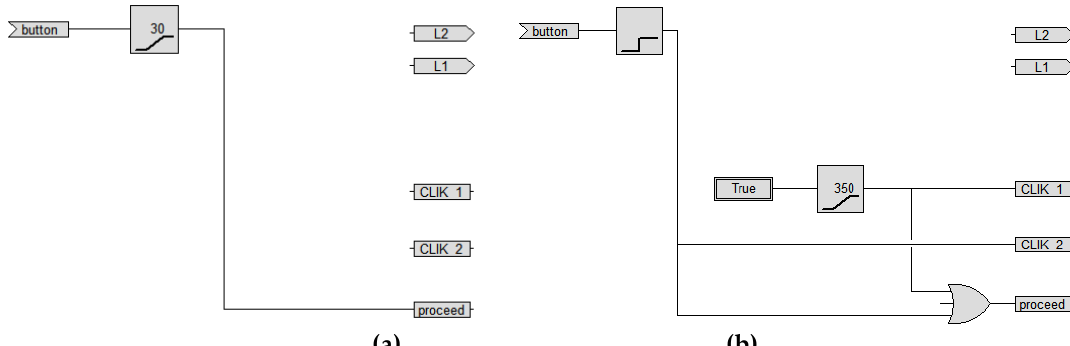
Figure 17. Data Flow of Step all_ON (normal case).